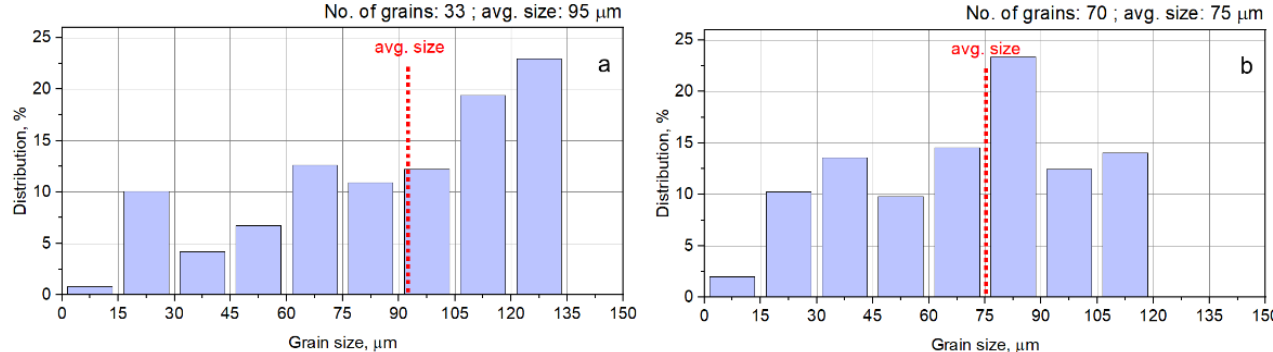
Figure 4. Grain size distribution of γ-phase in AR UNS S32750 Super-Duplex Stainless Steel ( a ); grain size distribution of δ-phase ( b ).